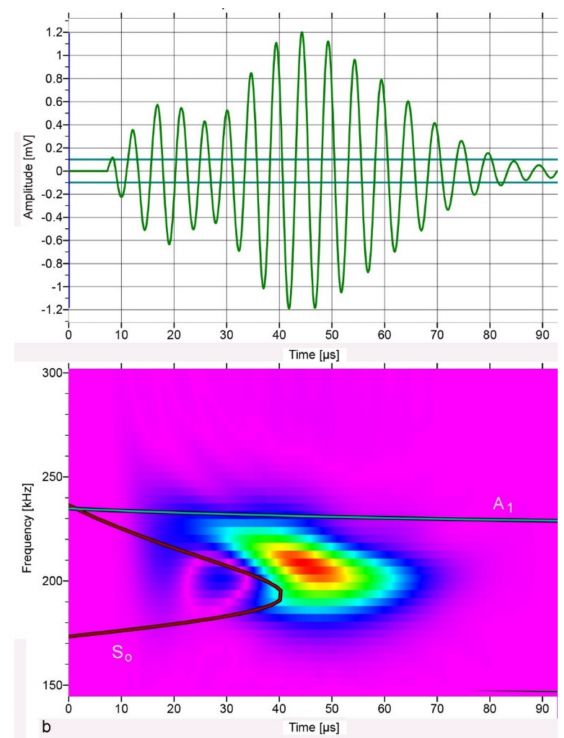
Figure 9. ( a ) Received signal and its WT spectrogram of α –S o test for Al-6061 plate of 12.7-mm thickness with 100-kHz excitation at 400 mm from the source. Transform start time was shifted by 75 µ s. Red and blue represent high and low WT intensities. Dispersion curves for S o , A o and A 1 modes are also plotted. ( b ) Received signal and its WT spectrogram of α –S o test for Al-6061 plate of 12.7-mm thickness with 200-kHz excitation at 400 mm from the source. Transform start time was shifted by 185 µ s. Red and blue represent high and low WT intensities. Dispersion curves for S o and A 1 modes are also